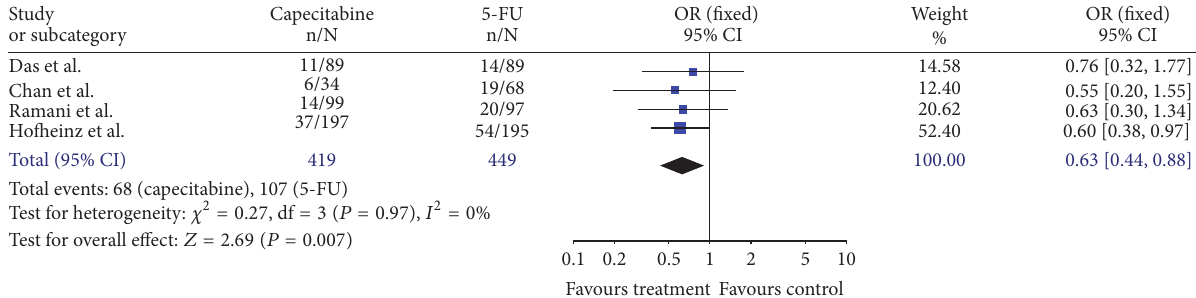
Figure 8: Forest plot of odds ratio (OR) for metastasis rate.